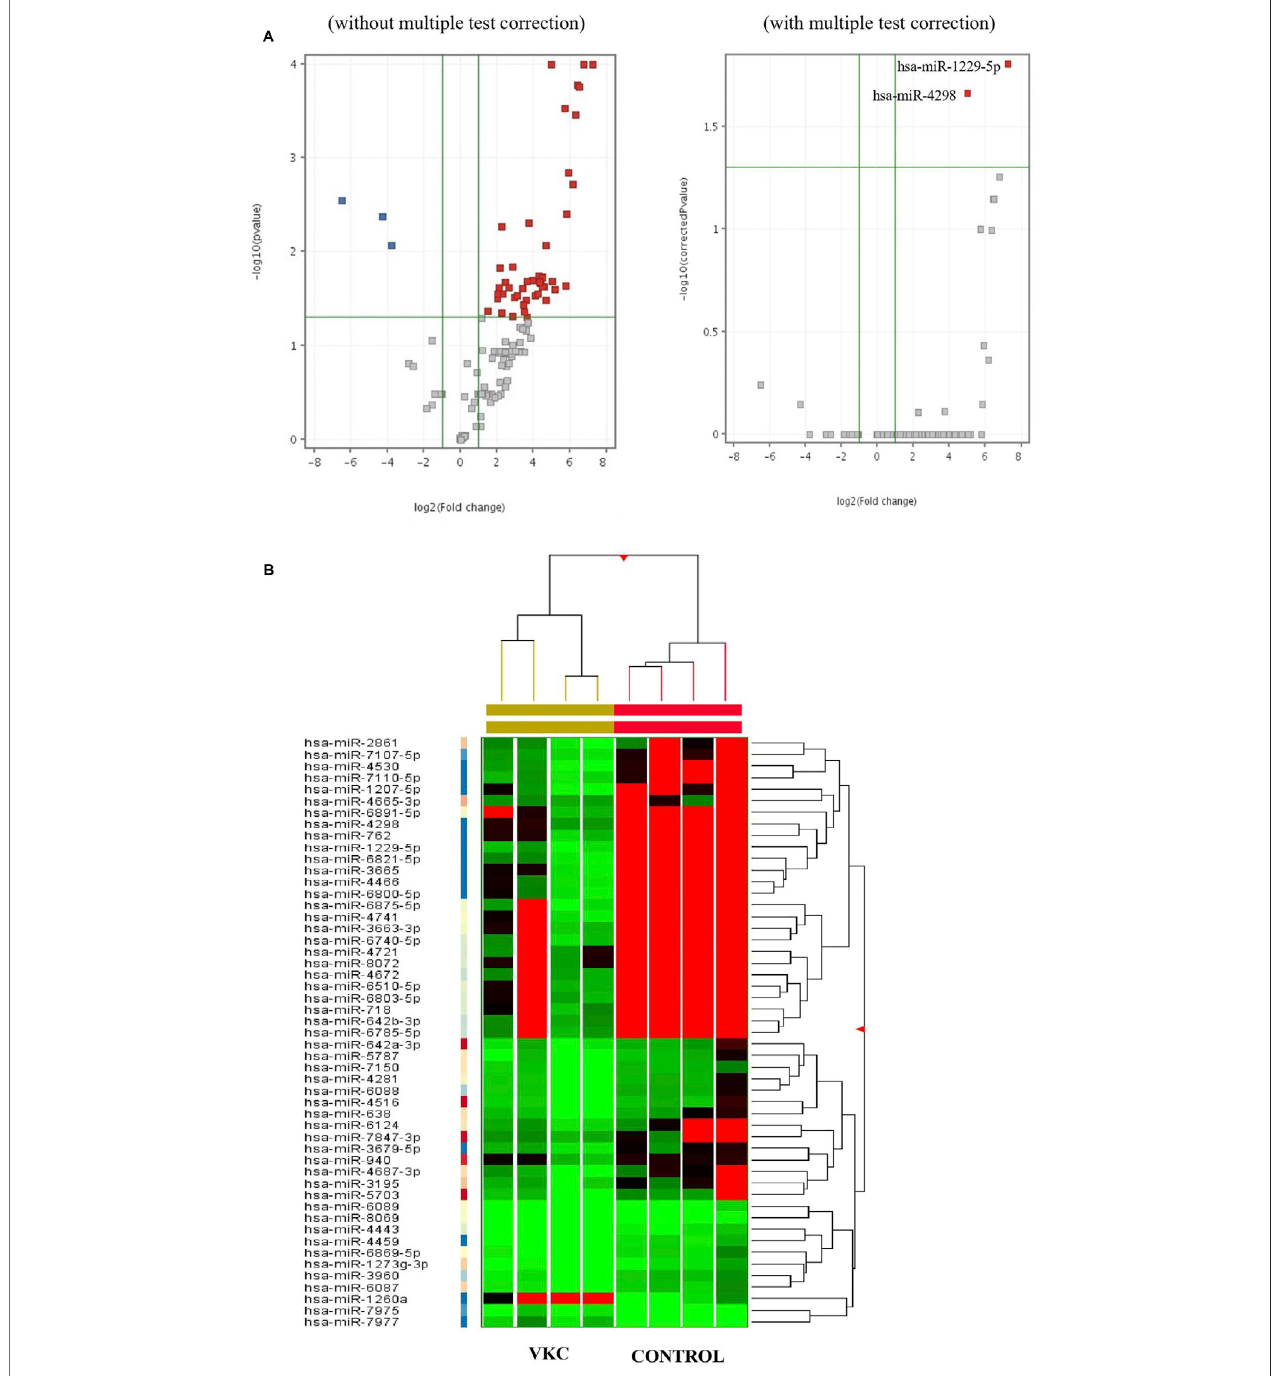
FIGURE 1 | (A) Volcano plots visualizing the differentially expressed miRNAs in the tears of children with VKC and control both before and after multiple test correction. (Red: Entities which pass both corrected p -value and fold change cut-offs and are up-regulated, Dark Blue: Entities which pass both corrected p -value and fold change cut-offs and down-regulated, Grey: Entities which neither pass both corrected p -value and fold change cut-offs.). (B) Clustered heat map of all signi fi cantly expressed miRNAs in tears of children with VKC compared to control children. Moderated t -Test, p ≤ 0.05 and FC ≥ 2.0.